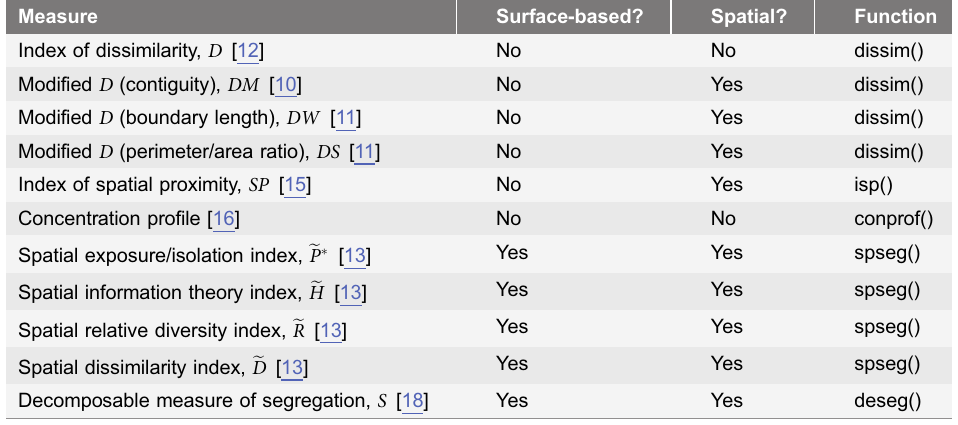
Table 1. A list of segregation measures currently implemented in the seg package. Measure Surface-based? Spatial?